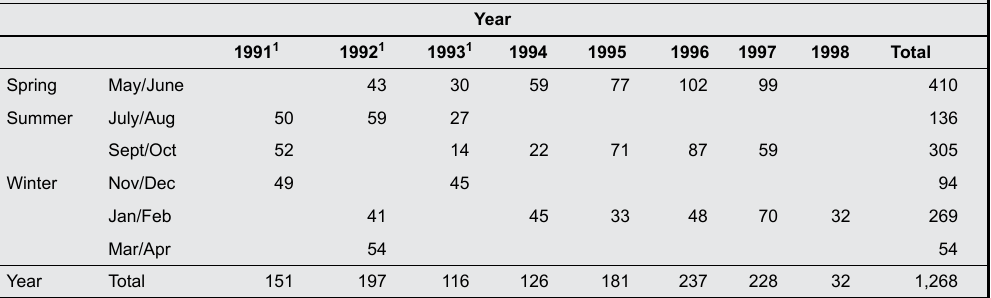
Table 1. Grey seal faecal samples containing prey hard parts collected at Sable Island,